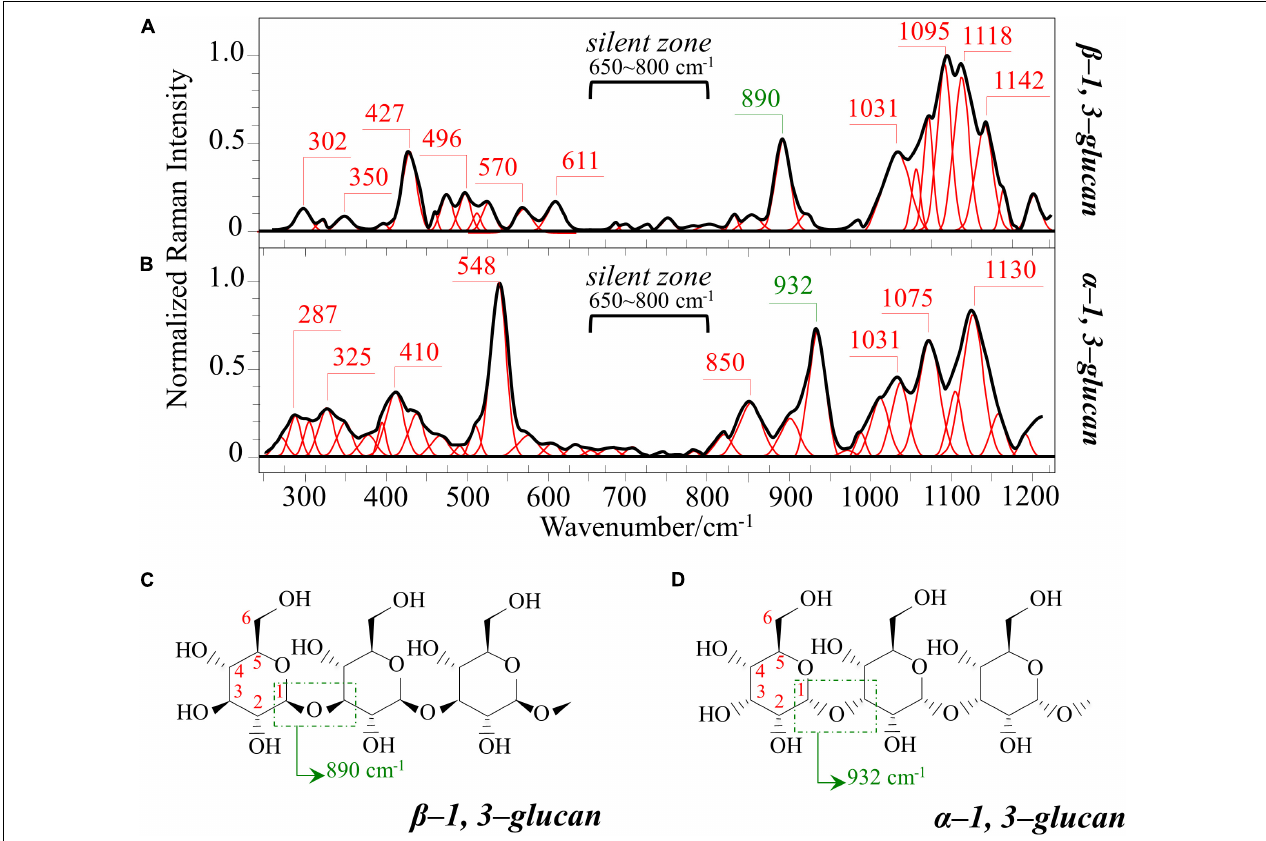
FIGURE 3 | Reference Raman spectra of: (A) β -1, 3-glucans and (B) α -1, 3-glucans (frequencies in cm − 1 of the main bands given by labels in inset); (C,D) the respective glucan structures (cf. labels in inset). The spectra are deconvoluted in series of Voigtian